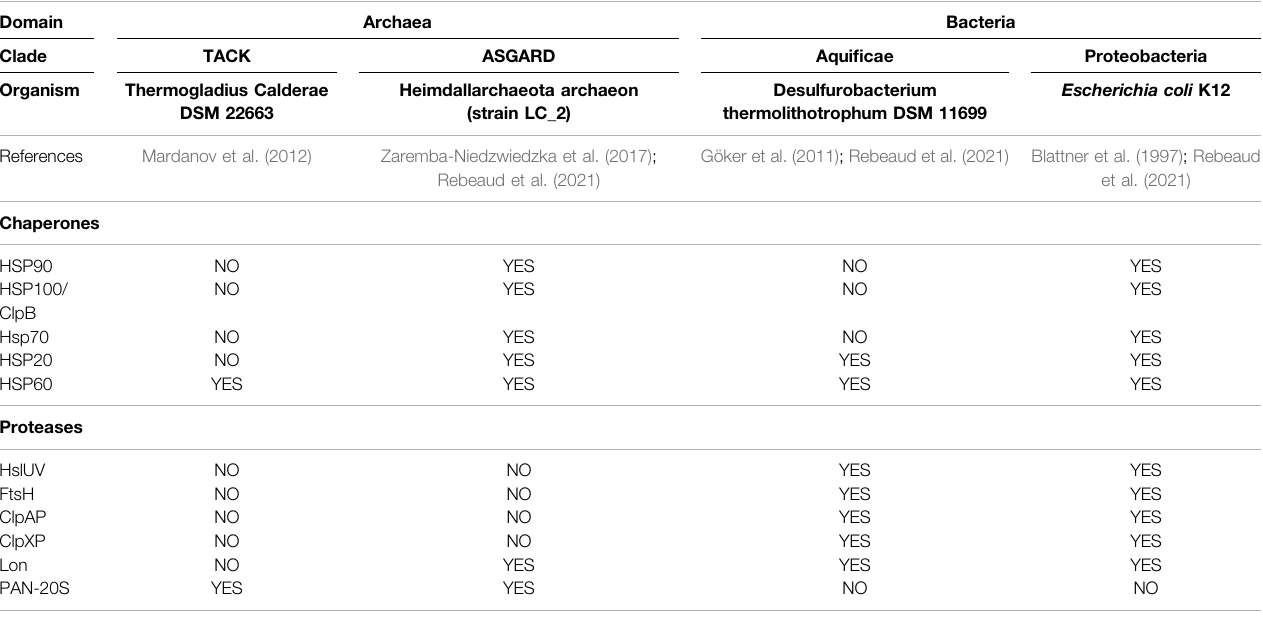
TABLE 1 | Absence (NO) or presence (YES) of individual core-chaperones and AAA+ proteases in the genomes of present-day free-living simple Archaea (TACK), simple Bacteria (Aqui fi cae), more complex Archaea (Asgard) and more complex bacteria (Proteobacteria).